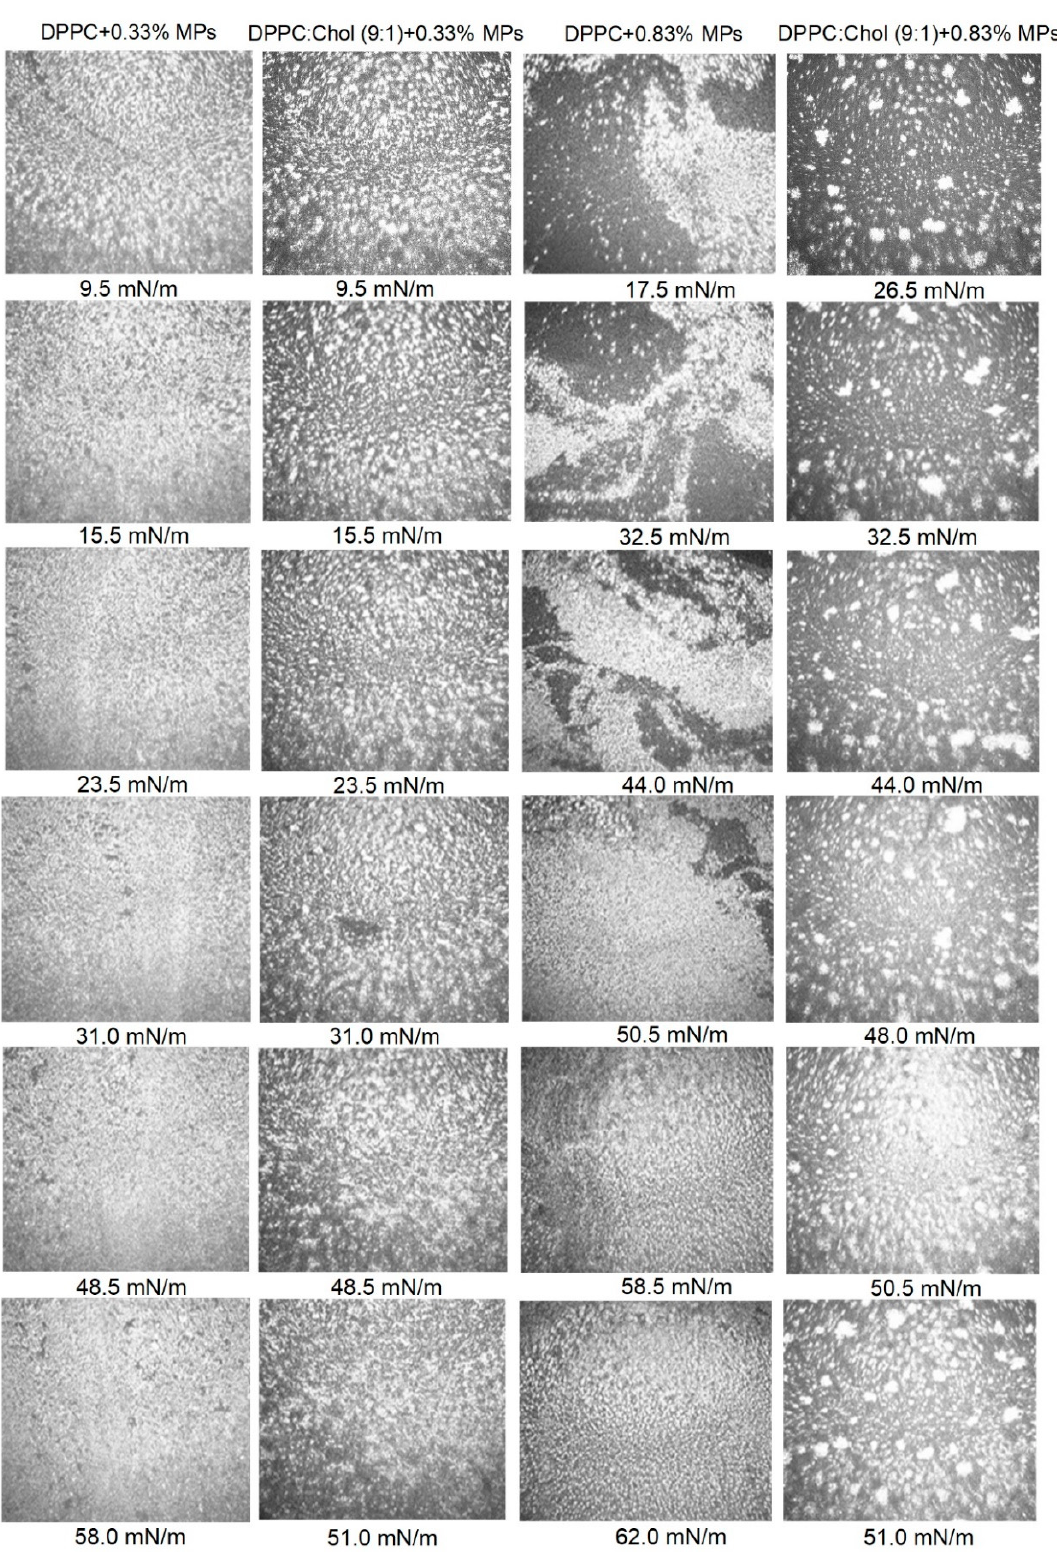
Figure 2. BAM images of DPPC + MPs and DPPC:Chol (9:1) + MPs at different surface pressures.